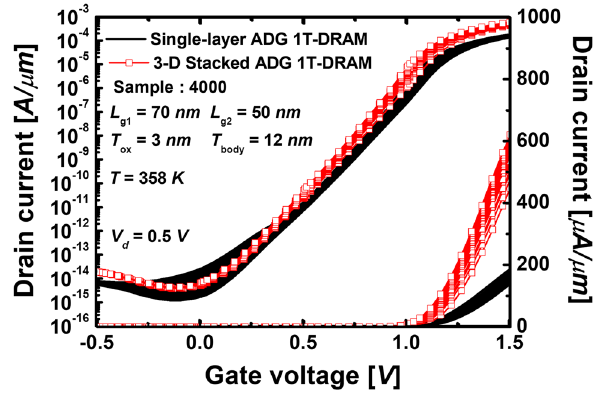
Figure 4. The I d – V g curves of 4000 samples of the single-layer ADG 1 T-DRAMs and the 3-D stacked ADG 1 T-DRAMs. The parameters adopted are L mg = 70 nm, L cg = 50 nm, T ox = 3 nm, T body = 12 nm, and T spacer = 30 nm.